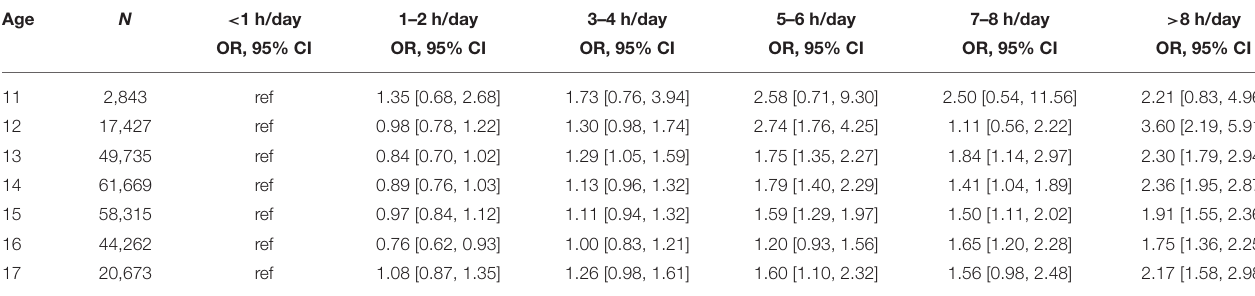
TABLE 2 | The relationship between sedentary time and anxiety-induced sleep disturbance estimated on multivariable logistic regression at different ages.